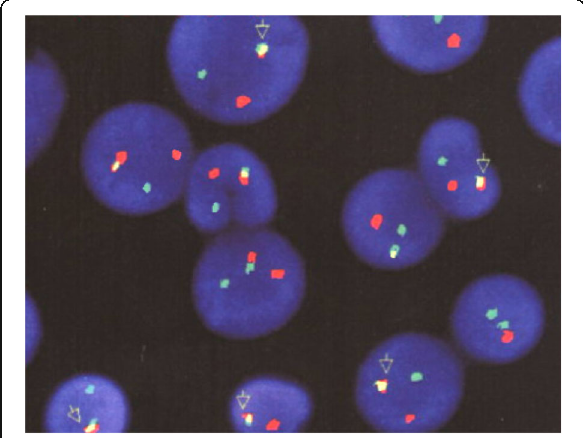
Fig. 2 An interphase FISH analysis applied at diagnosis using LSI single fusion (SF) probe BCR/ABL positive for t(9;22) (q34;q11), I yellow signal represents the typical fusion signal of translocation in addition to one green signal (BCR) and one red signal